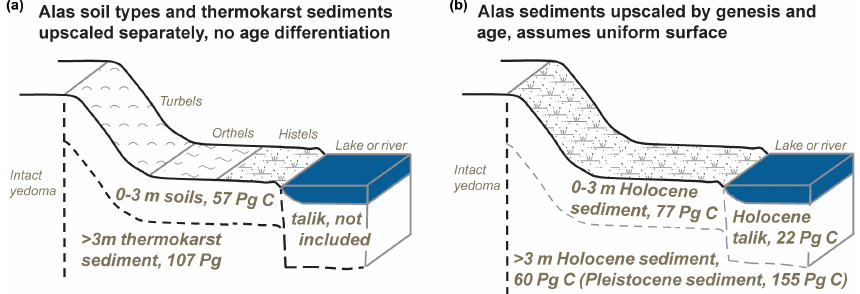
Figure 2. Conceptual diagram illustrating how organic soil/sediment C in Yedoma region alases is described and estimated by (a) Hugelius et al. (2014) and (b) by Walter Anthony et al. (2014). The graph depicts a Yedoma region alas, including its slopes and any thermoerosional gullies, with 14% water coverage. In (a) all numbers are derived from Hugelius et al. (2014). The near surface, 0–3m, soil carbon stocks (57PgC) were extracted from the NCSCDv2; thermokarst sediment carbon storage below 3m depth (107PgC) was calculated based on data from Strauss et al. (2013) and subaqueous sediments, which are typically non-permafrost, were not included. Note that in (a) the soil surface is subdivided to represent the areal coverage of different soil classes used in upscaling: Turbels 69%, Orthels 19% and Histels 13%. In (b) all numbers are derived from Walter Anthony et al. (2014) where carbon stocks are upscaled based on sedimentary facies descriptions which account for the age and genesis of sediment. Walter Anthony et al. (2014) do not actually separate near surface and subaqueous Holocene sediments in upscaling but in (b) these different compartments are shown to enable comparisons. The Pleistocene sediment C pool of 155PgC in (b) can be subdivided into 23PgC stored in subaqueous sediments and 132PgC stored in terrestrial sediments within 10m of the soil surface. See the online supplementary methods for details of